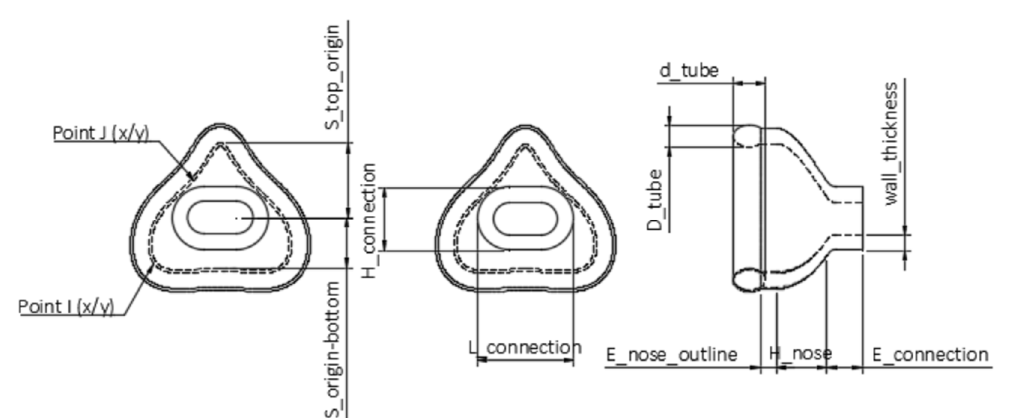
Figure 2. Technical drawing of the nasal mask obtained by Fusion 360. Top view in the left and middle images; side view in the right one. The scheme shows the user parameters.